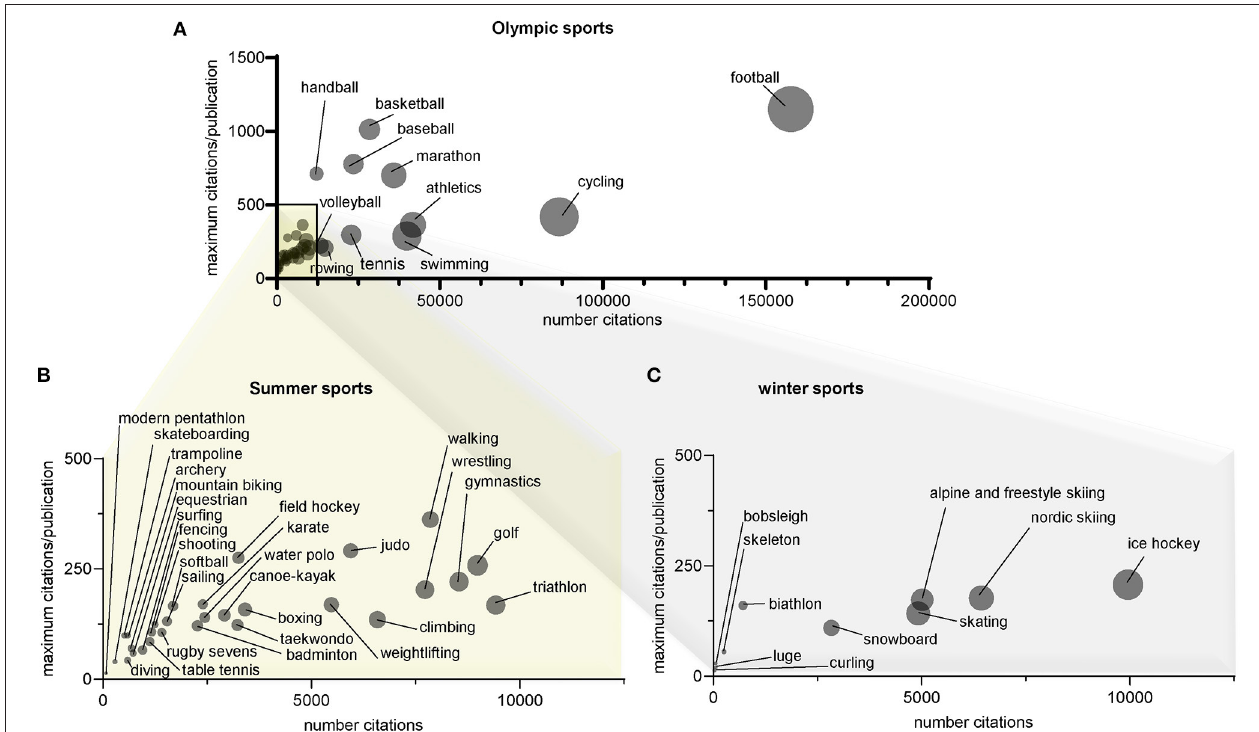
FIGURE 3 | Publication and citation numbers across all Olympic sports. All Olympic sports are depicted in panel (A) . Zooms of sports with citation ranges from 0 to 12,500 citations and maximum citations/publication of 500 are provided in (B) for summer and (C) for winter Olympic sports. Bubble sizes reflect numbers of publications for each sport relative to the greatest bubble of each panel. Highest publication numbers: (A) football—4,937, (B) golf—491, and (C)